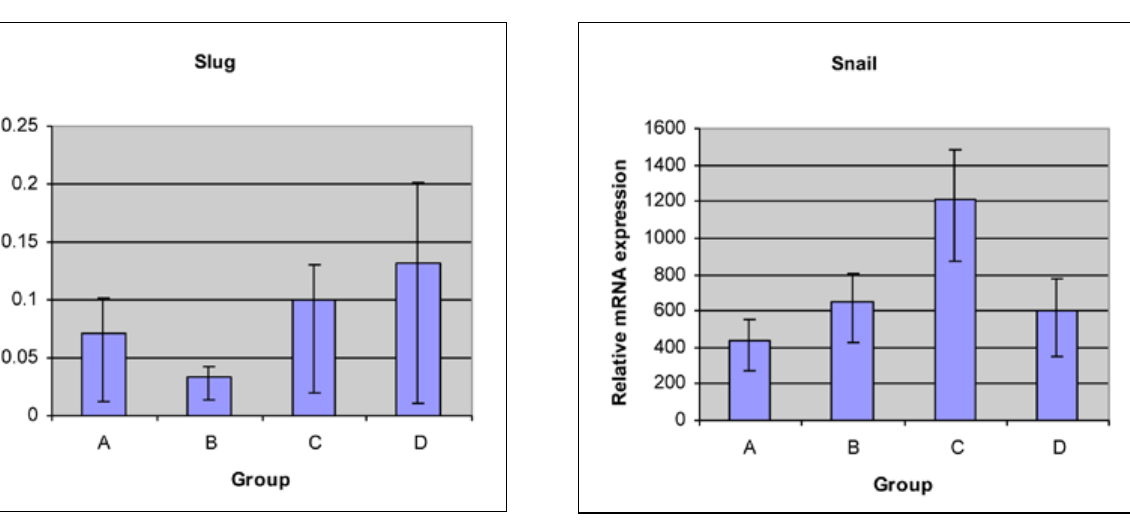
Figure 5. Expression of Snail by human embryonic stem cells – Day 8 (NS p < 0.05). * p < 0.05, reflecting a significant difference between the means of the